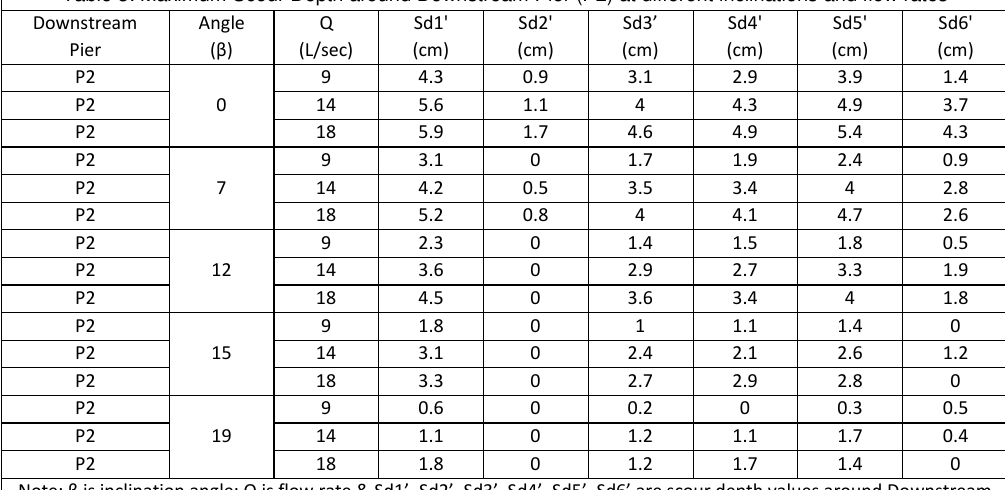
Table 3: Maximum Scour Depth around Downstream Pier (P2) at different inclinations and flow rates Downstream Pier